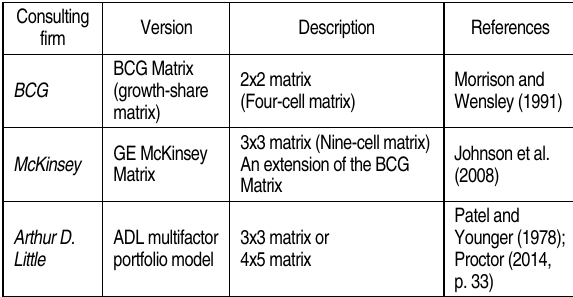
Table 5. Portfolio matrices offering by leading con- sulting